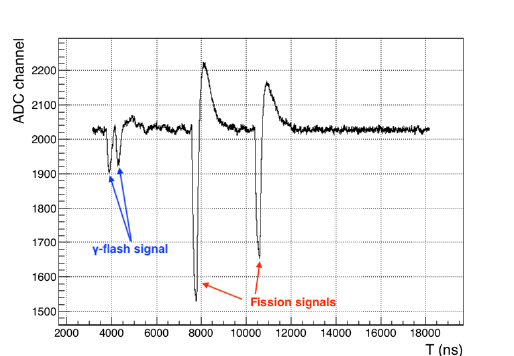
Figure 2: MFC setup at Back-n #ES1.